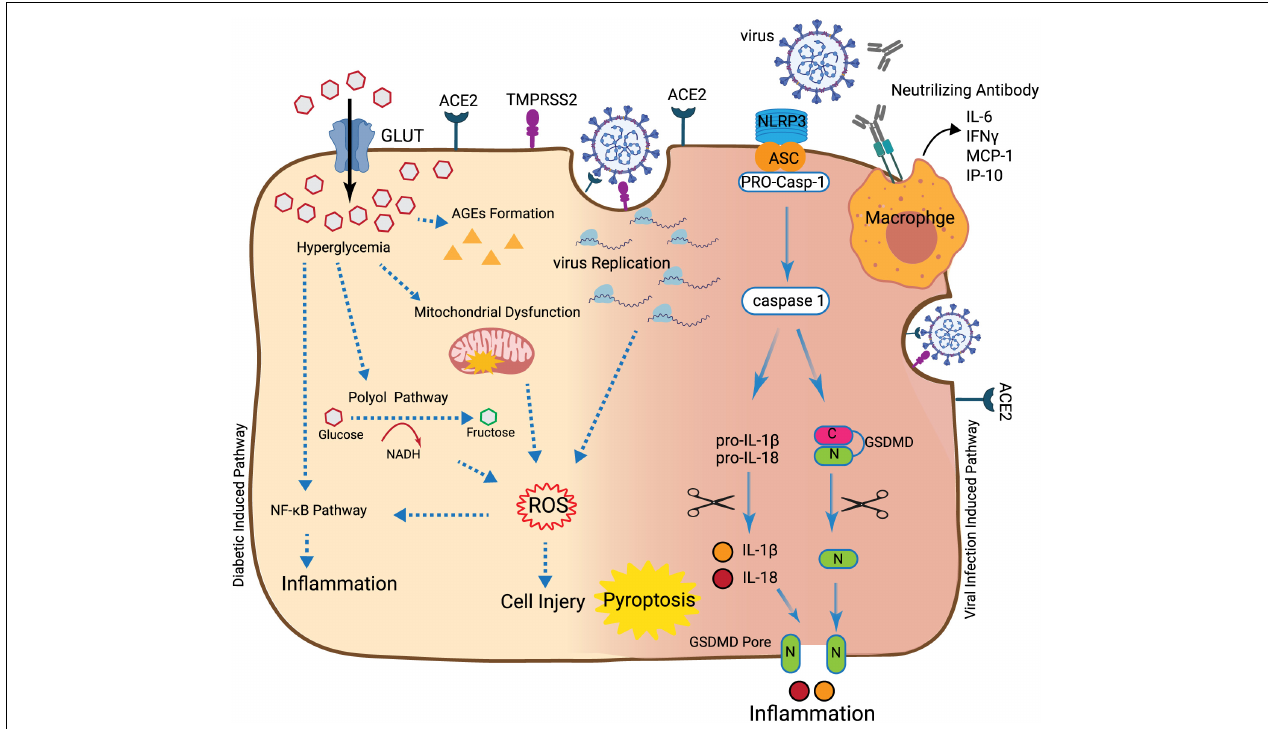
FIGURE 1 | Synergic destructive effects of diabetes and SARS-CoV-2. In the hyperglycemia situation, accumulation of glucose into the cell can induce mitochondrial dysfunction, production of AGEs and polyol pathway activation that can induce ROS. Production of ROS can lead to cell injury and also inflammation through activation of the NF κ B pathway. Also, after the virus enters into the cell through ACE2, the initial virus replication can lead to ROS induction. Once more, ROS can induce inflammation through activation of the NF κ B pathway or induction of macrophage activity. Recognition of the virus by NLRP3 at the cell surface leads to binding of NLRP3 to the pro-caspase-1 through the ASC. This connection activates caspase-1 which leads to the cleavage of pro-inflammatory cytokines like pro-IL-1 β , pro-IL-18, and GSMD. This results in the production of mature IL-1 β and IL-18 and N-terminal products, respectively. N-terminal products located into cell membranes result in the creation of the GSMD pore. Following cell perforation and release of the cellular content into the extracellular space, inflammation, cell swelling, and pyroptosis can occur. After appearance of the adaptive immune response, generation of neutralizing antibodies and binding of macrophage